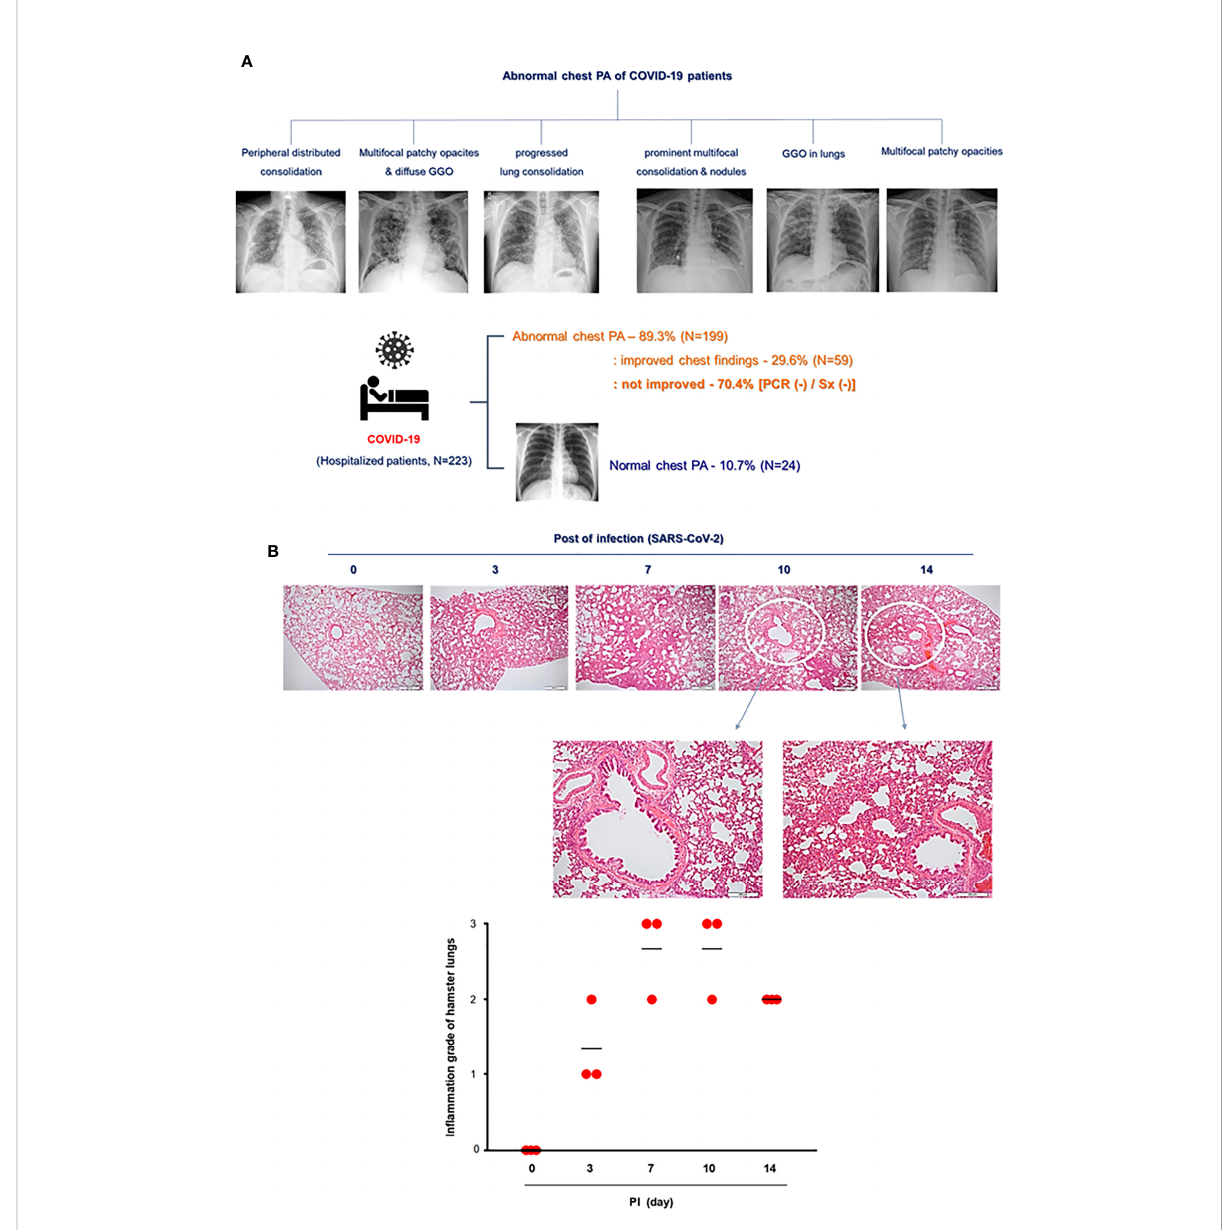
FIGURE 2 Lung histopathologic fi ndings in COVID-19 patients and CoV2+ hamsters. (A) The clinical analysis of hospitalized COVID-19 patients (N = 223) and the fi ndings of chest PA in COVID-19 patients with abnormal chest x-ray readings until discharge. Syrian golden hamsters were used in these experiments. The hamsters were infected with SARS-CoV-2 (BetaCoV/Korea/SNU01/2020, 2.5 × 10 5 TCID50/hamster) at the indicated time points (N = 3 at each indicated time point). (B) H&E-stained micrographs were also generated from lung sections of hamsters obtained at indicated time points of SARS-CoV-2 infection (scale bar = 100 µM). Micrographs shown are representative of lung sections from three hamsters and were used to assess the in fl ammation and tissue damage and to calculate a histological